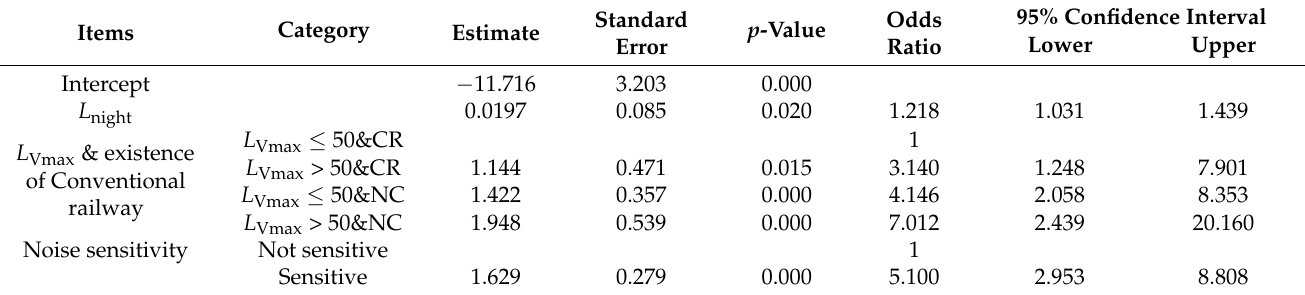
Table 7. Multiple logistic regression analysis of the frequency of the awakening by L night , L Vmax and existence of conventional railway (AUC =